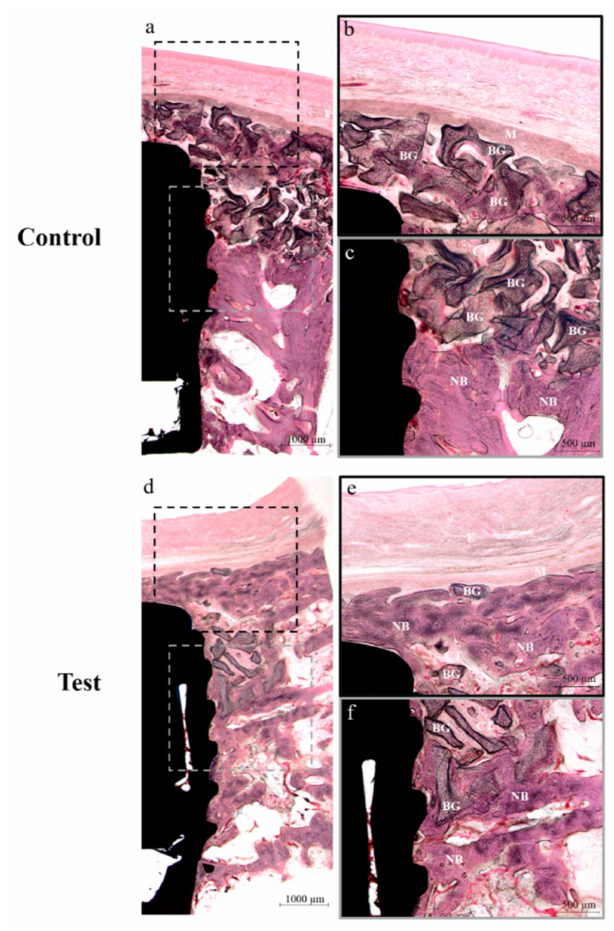
Figure 7. Histological sections images stained with hematoxylin-eosin (H&E) obtained after transplantation for 8 weeks. ( a – c ) Control group, ( d – f ) Test group. E, Epithelium; M, Membrane; BG, Bone grafts; CT, Connective tissue; NB, New bone. Control is represented by non-cross-linked collagen membrane; Test is represented by EDC-cross-linked collagen membrane. Original magnification: × 12.5 ( a , d ); × 40 ( d , c , e , f